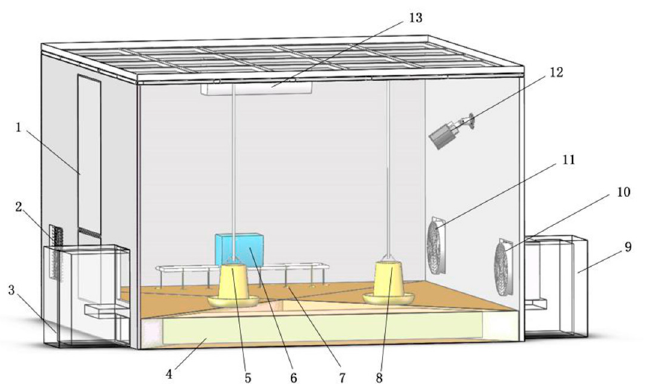
Figure 3. The three-dimensional chamber model was established by SolidWorks with (1) chamber